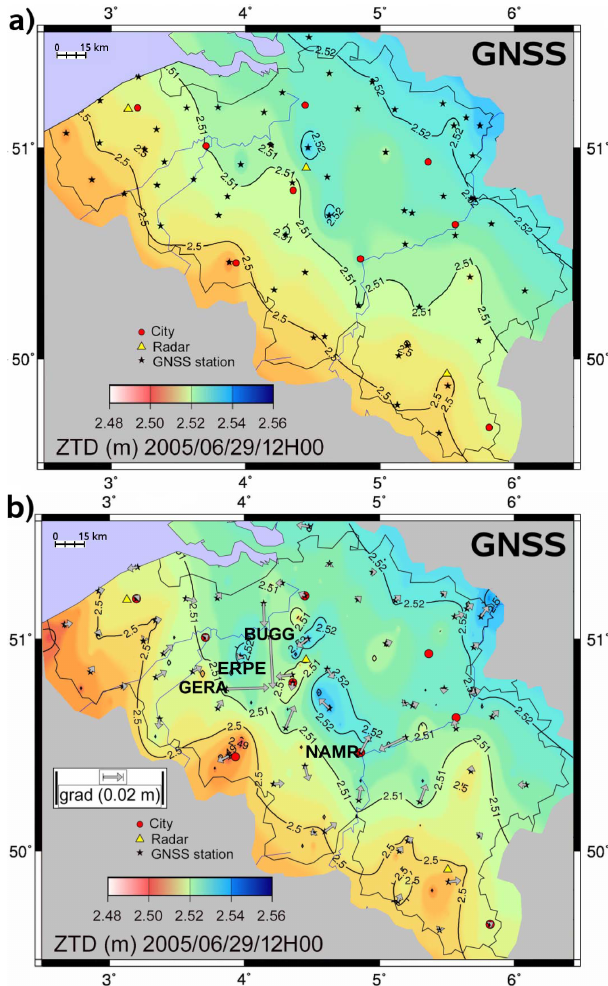
Figure 10. (a) Imaging of the 2-D field of ZTD with a classic in- terpolation (stations are plotted by black stars); (b) improvement −→ of this field by GNSS gradients. These gradients G are plotted by grey arrows at each GNSS site. BUGG, ERPE, GERA and NAMR stations are plotted. Locations of 9 major Belgium cities (red cir- cles) and meteorological radars (yellow triangles) are also plotted on these 2-D